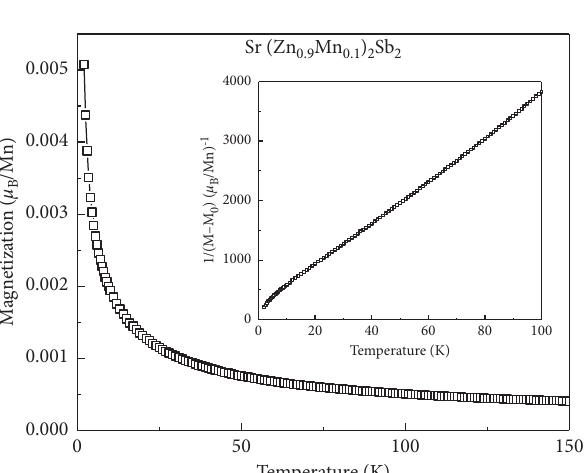
Figure 2: The temperature dependence of magnetization for Sr ( Zn ∼ 100Oe. Inset: the plot of 1/ ( M − M field B ext